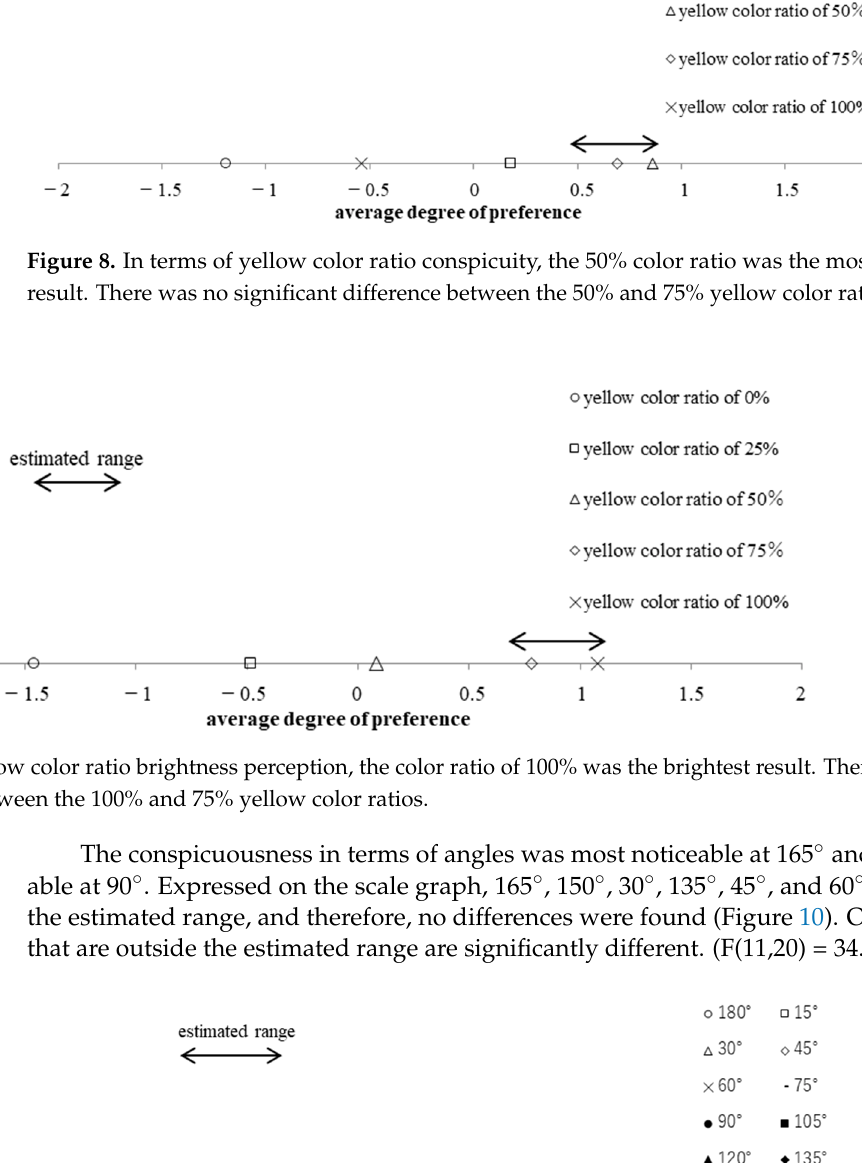
Figure 8. In terms of yellow color ratio conspicuity, the 50% color ratio was the most conspicuous result. There was no significant difference between the 50% and 75% yellow color ratios.